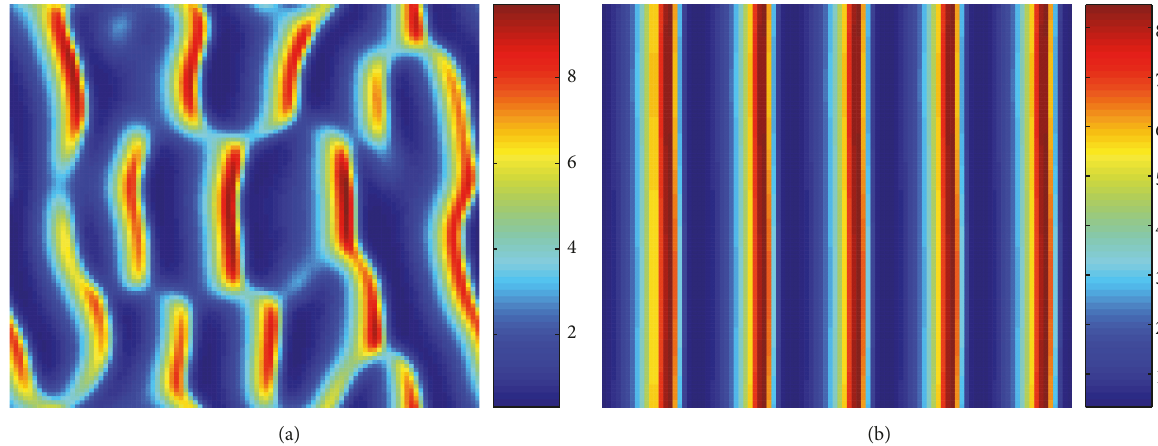
Figure 4: Self-organization of a regular banded vegetation pattern on planar hillslopes when 𝐴 = 6.00 × 10 −3 . (a) 𝑇 = 1000; (b) 𝑇 = 20000. The downslope direction is from left to right in each graph and in the pattern graphs below.